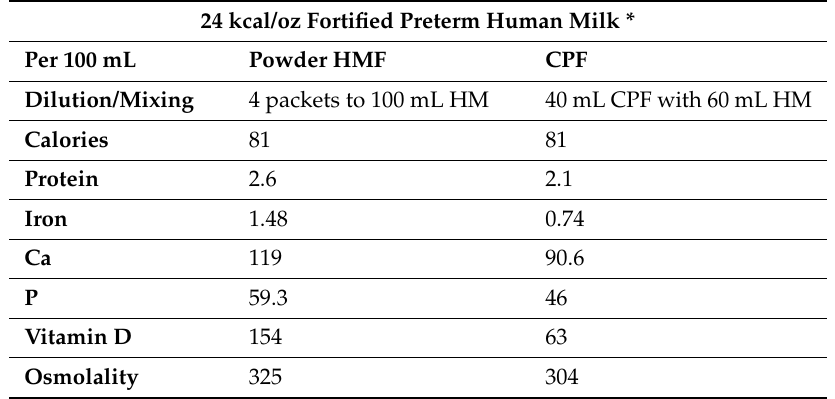
Table 1. Comparison of powder human milk fortifier (HMF) and concentrated preterm formula